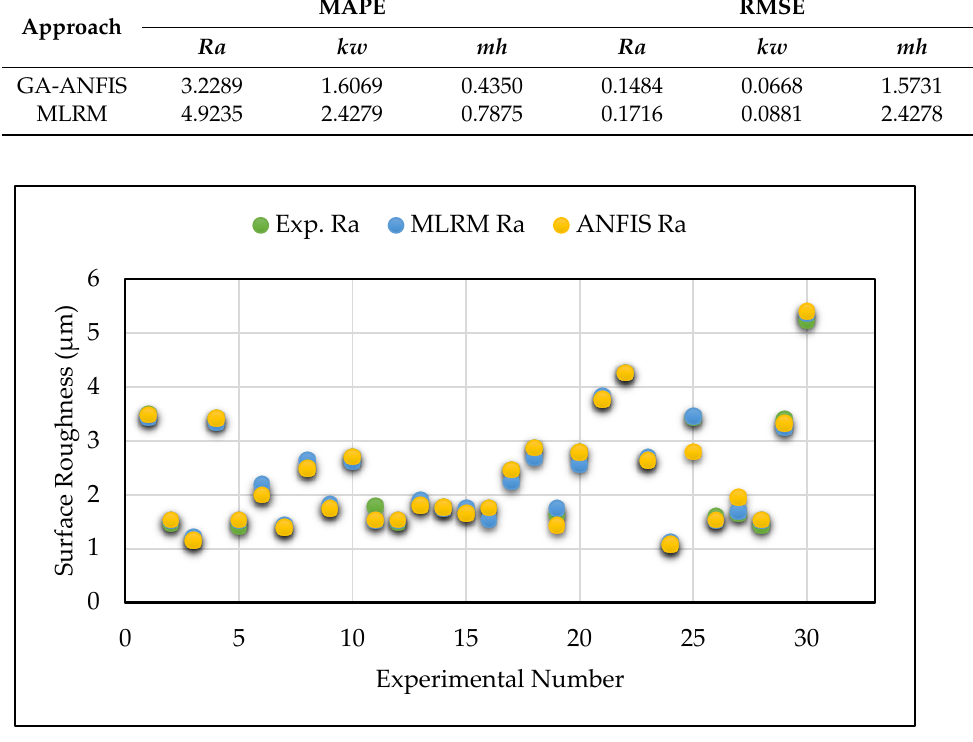
Figure 8. Comparison of ANFIS and MLRM predicted vs. experimentally measured surface rough- ness values.